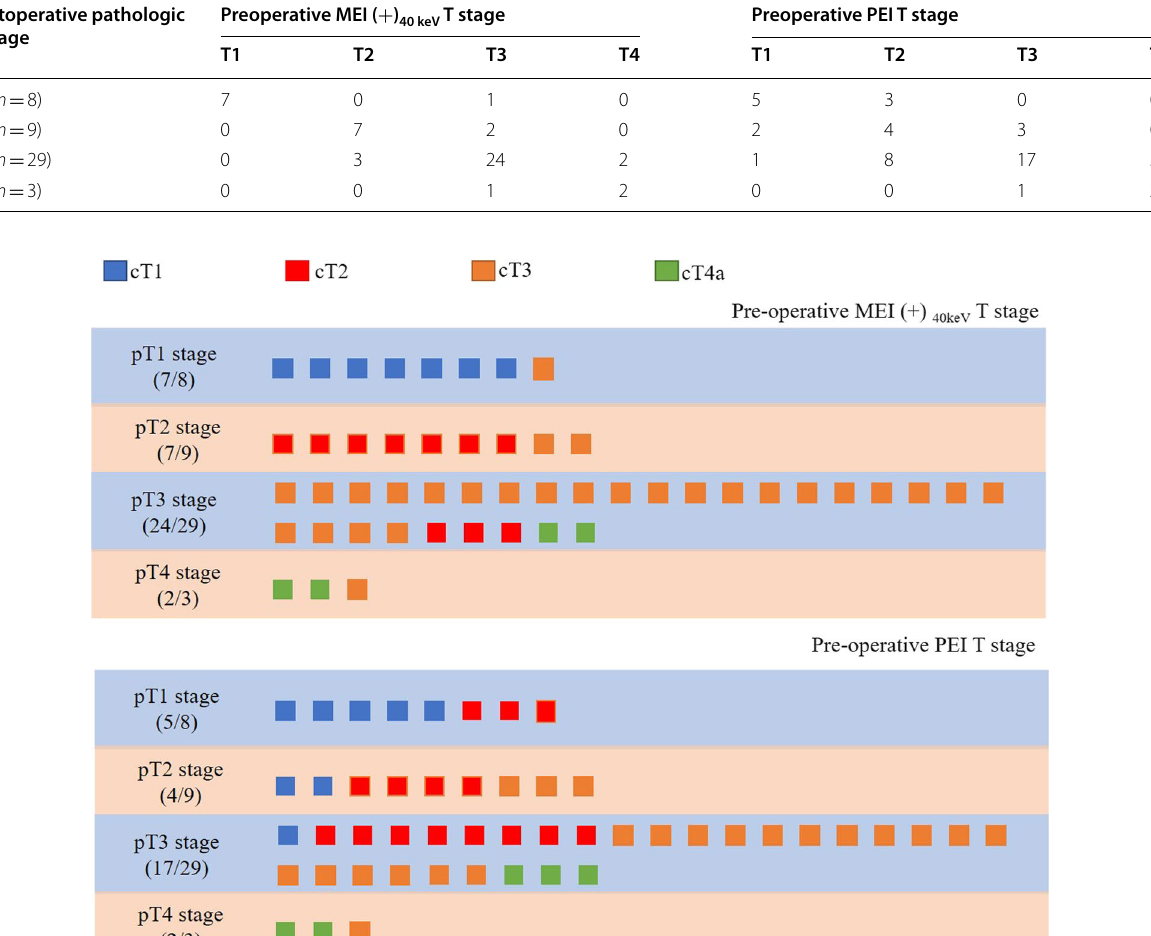
) 40 keV and pathologic T categories +